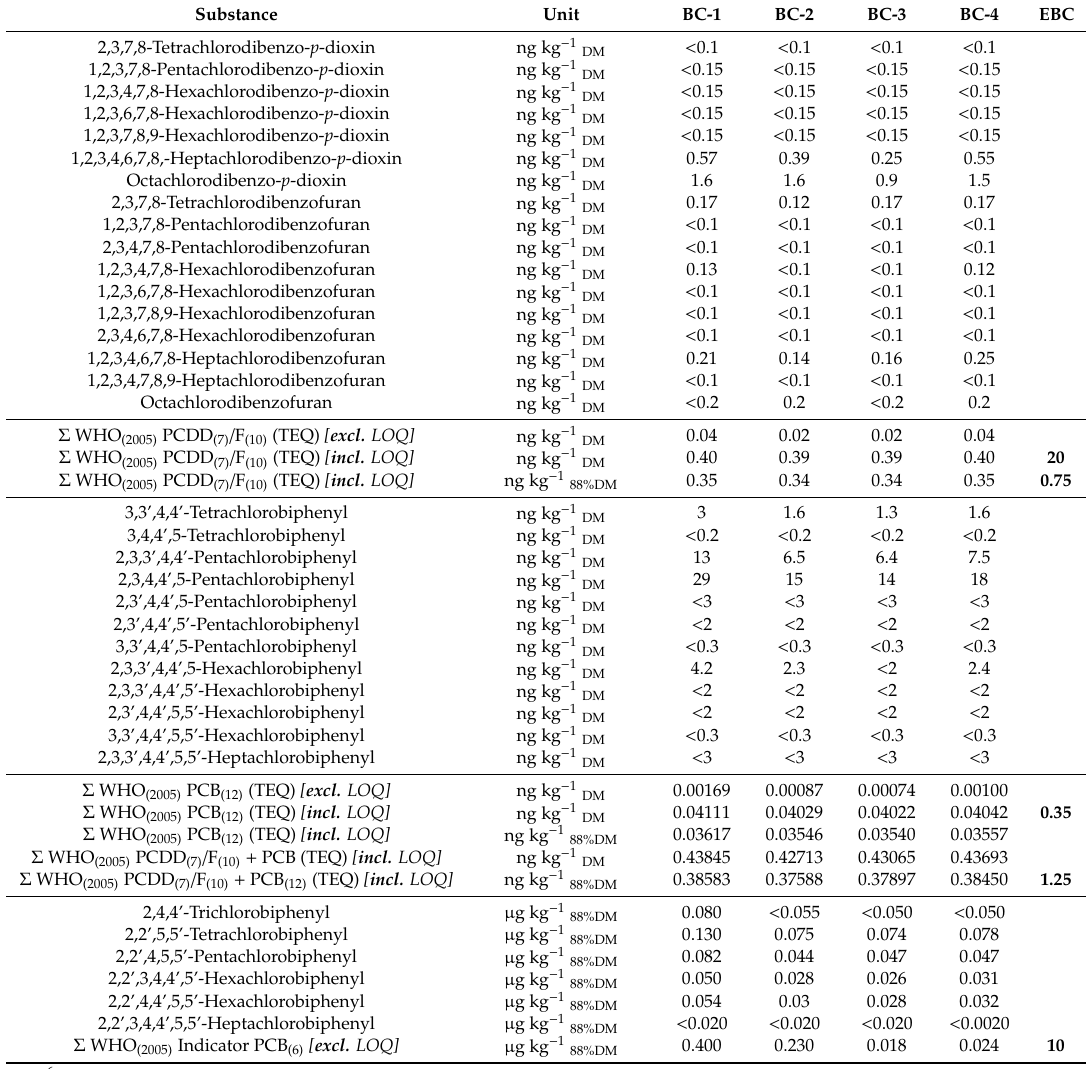
6 . Abbreviations: WHO (2005) , values based on World Health Organization toxic equivalency factor from 2005; PCDD (7) , 7 EBC required polychlorinated dibenzo- p -dioxins; PCDF (10) , 10 EBC required polychlorinated dibenzofurans; TEQ, toxicity equivalency quotient; LOQ, limit of quantitation; PCB (12) , 12 EBC required polychlorinated biphenyls; PCB (6) , 6 EBC required indicator polychlorinated biphenyls; DM, dry